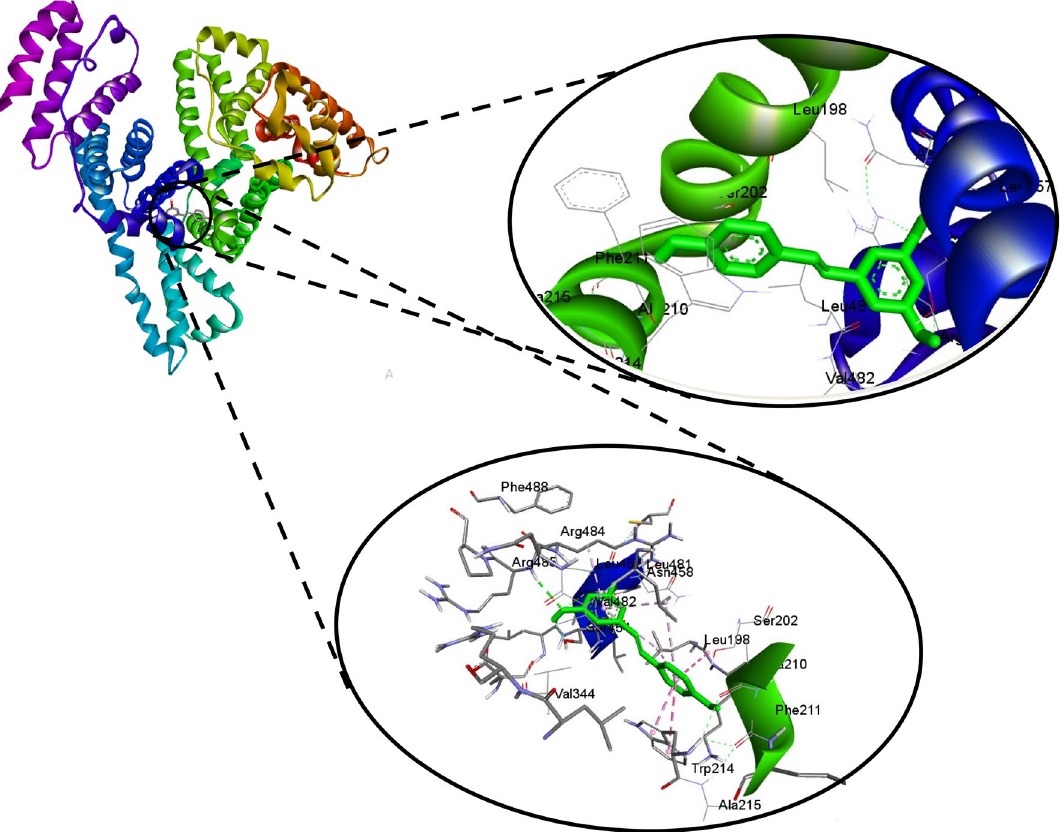
Figure 10. Molecular docking of trans -resveratrol with HSA showing the best docked pose, site of binding and the amino acid residues involved in the complex stabilization.